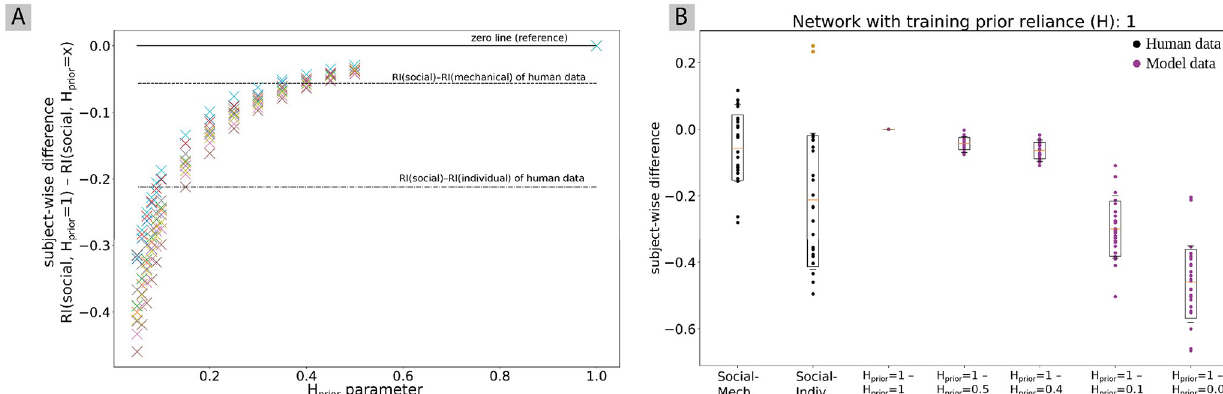
Fig 5. Difference between the regression index of networks produced using the 25 initial states of the social condition with regular prior reliance ( H prior = 1) and the regression index produced with the same initial states using increased ( H prior < 1) prior reliance. (a) For all ten networks the median of the subject-wise difference is displayed. Horizontal lines mark the zero line, the average subject-wise difference in the regression index between the social and the mechanical condition in human data, and the average subject-wise difference in regression index between the social and the individual condition. (b) Detailed results including all subject data for a single network. The subject-wise differences between the behavior using social initial states of H = 1 vs. H = x for different x values is